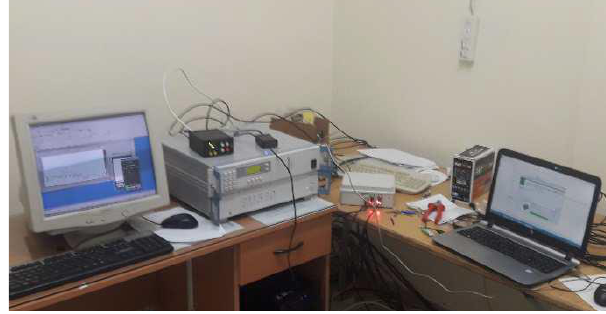
Figure 14. The set-up used in the testing and validation phase.